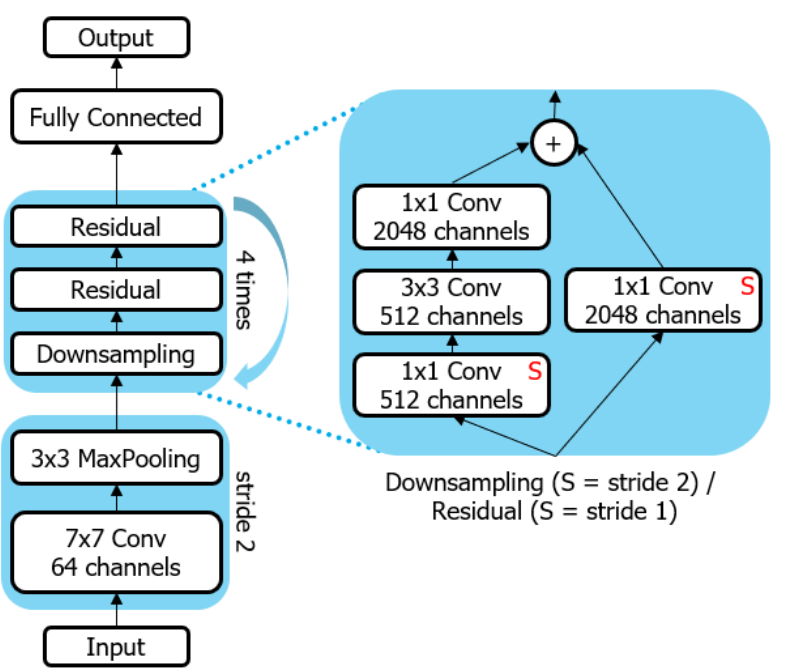
Figure 2. ResNet50 architecture. The architecture consists of several sequential blocks: an initial pre-processing block, four sequential blocks each consisting of a downsampling and two ResNet typical residual blocks, and a fully connected output layer. Convolution kernel sizes and number of output channels are provided. Furthermore, stride is taken as one where not shown